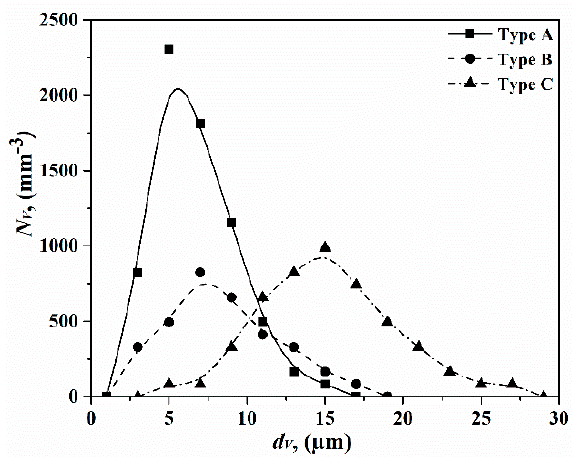
Figure 4. Particle size distributions of type A, type B, and type C inclusions in FeB alloys.